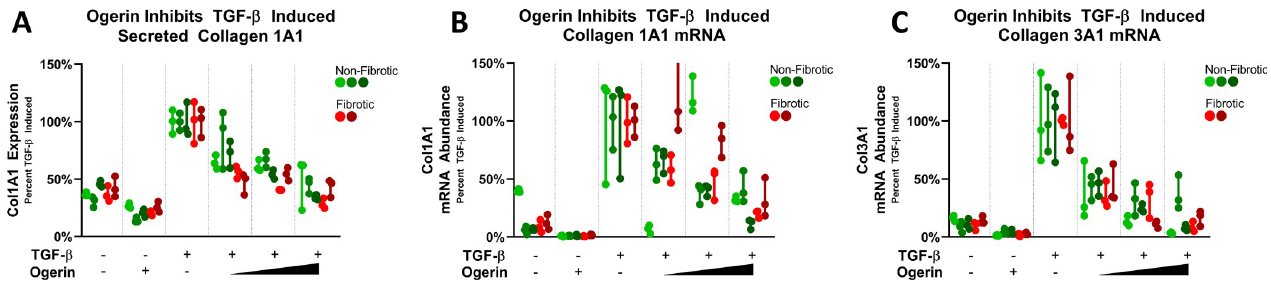
Fig 2. Ogerin inhibits TGF- β induced collagen production in primary human lung fibroblasts at the transcriptional level. A: Primary human lung fibroblasts derived from non-fibrotic or IPF patients were co-treated with 1ng/mL TGF- β and/or 50–150 μ M Ogerin for 72 hours. Cell culture supernatant was analyzed for secreted Col1A1 via slot blot. Band densitometry was standardized as percent TGF- β induced. n = 3 per donor per treatment group, bars representative of technical replicate range. Statistics omitted for clarity, individual plots with statistical analysis provided in S3B and S3C Fig. Primary human lung fibroblasts derived from non-fibrotic or IPF patients co-treated with 1ng/mL TGF- β and/or 50–150 μ M Ogerin for 48 hours. Col1A1 and Col3A1 mRNA transcript levels analyzed via qRT-PCR. Transcript abundance standardized to 18s rRNA by the ΔΔ Ct method and expressed as percent TGF- β induced. Statistics omitted for clarity, individual plots with statistical analysis provided in S4 and S5